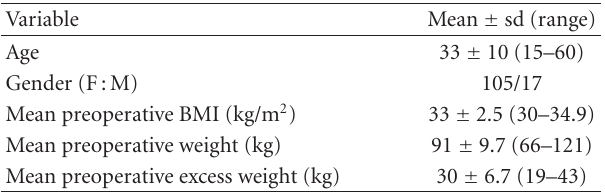
Table 1: Patient demographics.